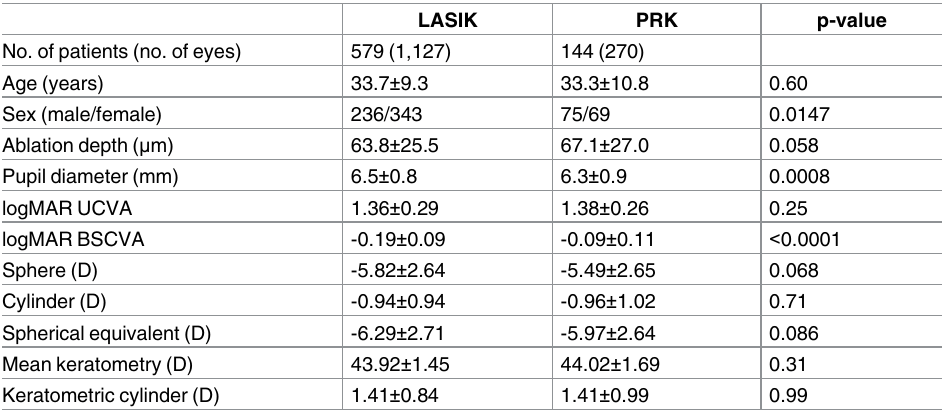
Table 1. Demographic